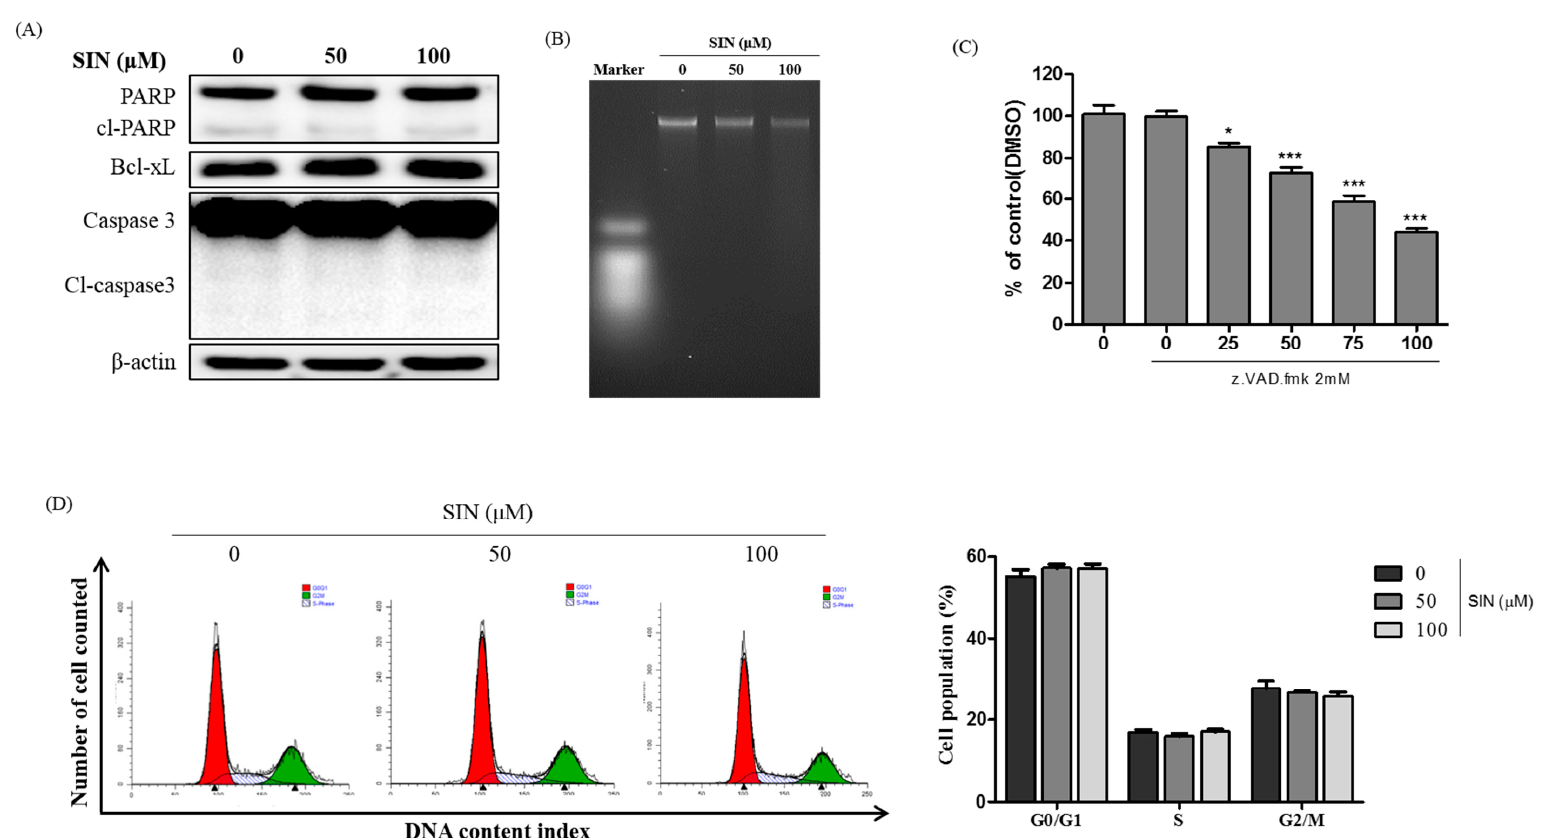
Figure 2. SIN does not induce apoptotic cell death in HepG2 cells. ( A ) HepG2 cells were treated with SIN for 48 h. Immunoblotting analysis of apoptosis markers, cleaved-PARP, cleaved-caspase-3, and Bcl-xL, was performed. β -actin protein was used as a loading control for the analysis. ( B ) The cells were exposed with SIN for 48 h, and then total DNA was isolated and separated on 1.2% agarose gel. ( C ) Cells were exposed to SIN in the presence or absence of 2 mM z.VAD.fmk. Cell viability was examined by the MTT method. ( D ) HepG2 cells were treated with SIN for 48 h, then fixed and stained with propidium iodide (PI). Cell cycle was analyzed with flow cytometry. The mean ± SEM of three independent experiments are expressed as a percentage compared with vehicle control. * p < 0.05 vs. vehicle control; *** p < 0.001 vs. vehicle